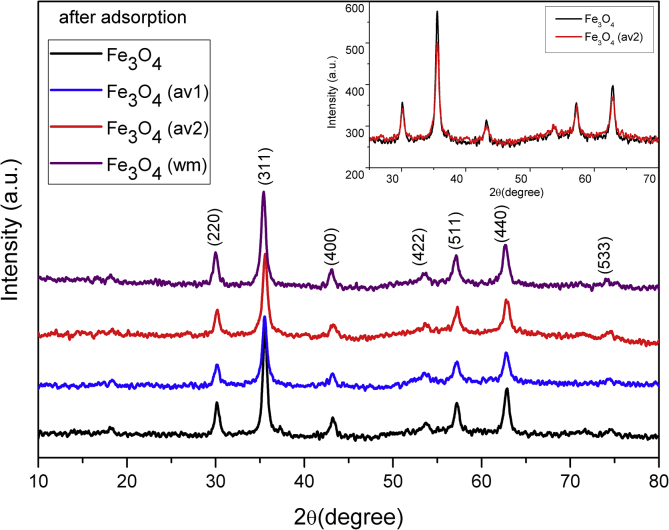
XRD patterns for ST-coated Fe3O4 NPs after adsorption of OB.